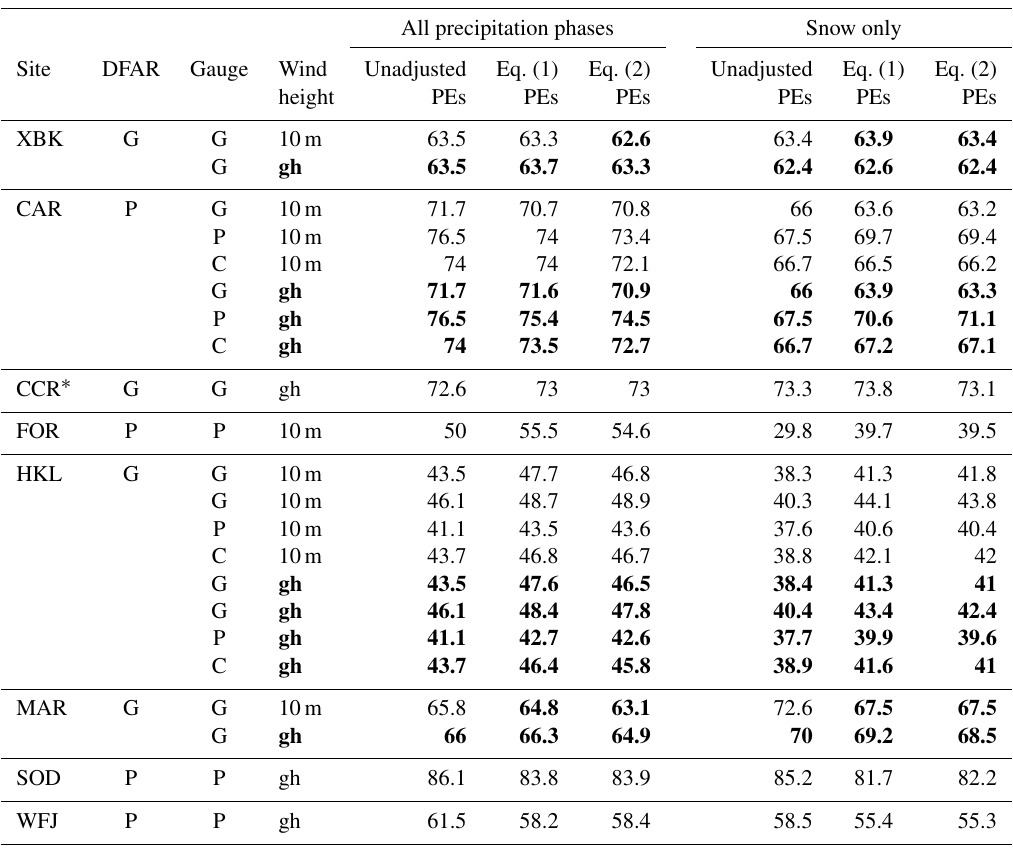
Table 8. Percentage of events (PEs) that differ from the DFAR by less than 0.1mm for the single Alter-shielded gauges (G – Geonor; P – Pluvio 2 ) at each site for the combined winters of 2015/2016 and 2016/2017 for available wind speed measurement heights (10m; gh – gauge height) and for Eqs. (1) and (2). Metrics are separated by precipitation phase (all and snow only). Where both wind speed heights are available, the gauge height data are shown in